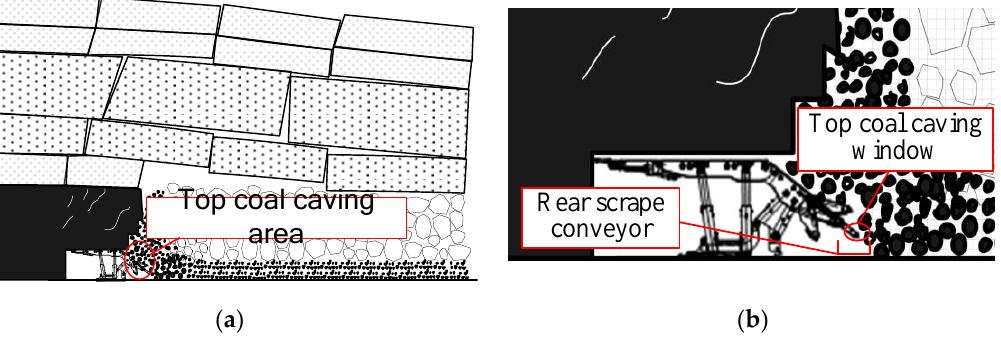
Figure 1. Schematic diagram of LTCC working face. ( a ) Top coal caving area; ( b ) Enlarged top coal caving area.